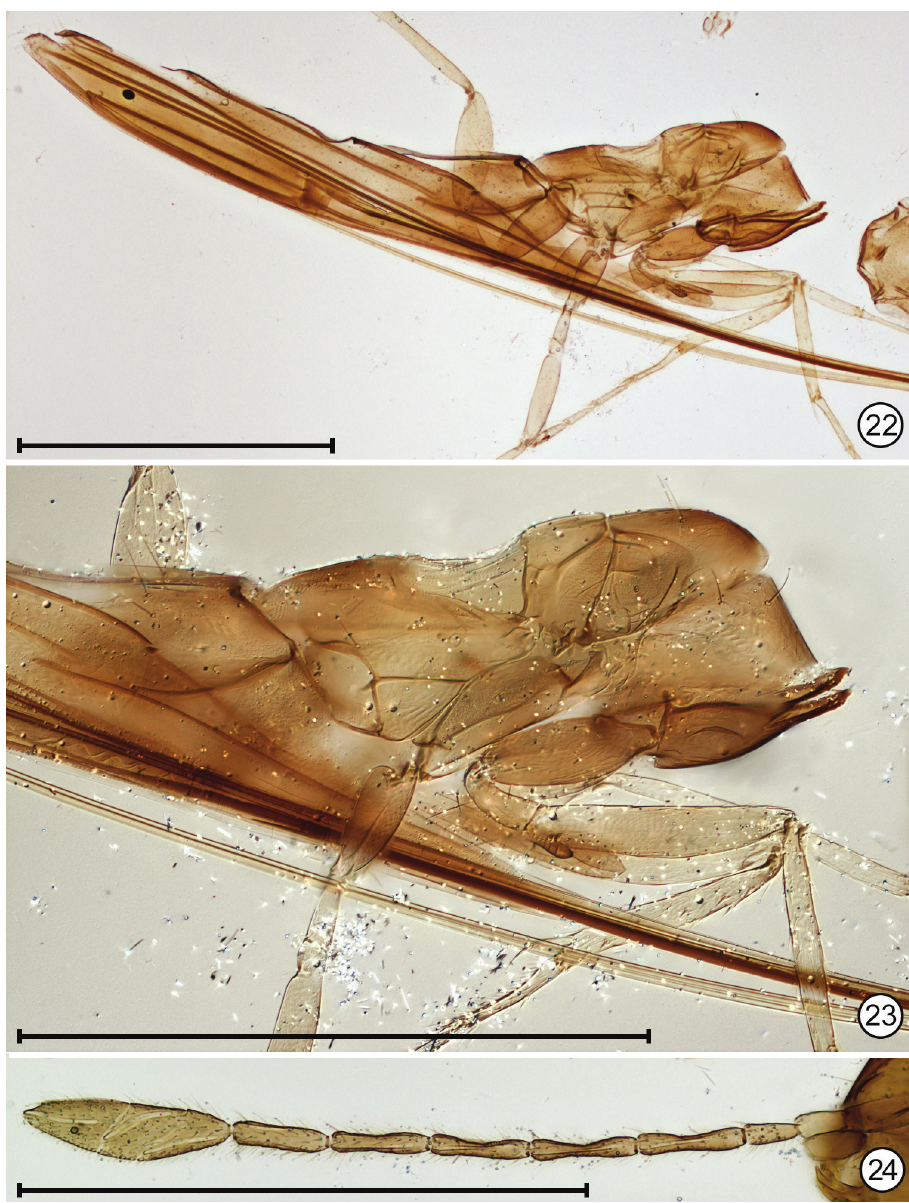
Figures 22–24. Paranaphoidea africana holotype 22 mesosoma + metasoma, lateral 23 mesosoma + base of metasoma, lateral 24 antenna. Scale bars: 500